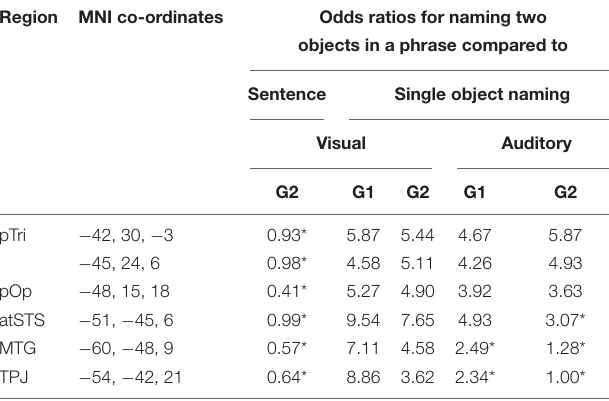
TABLE 3B | Statistical comparison of naming one or two objects per trial.